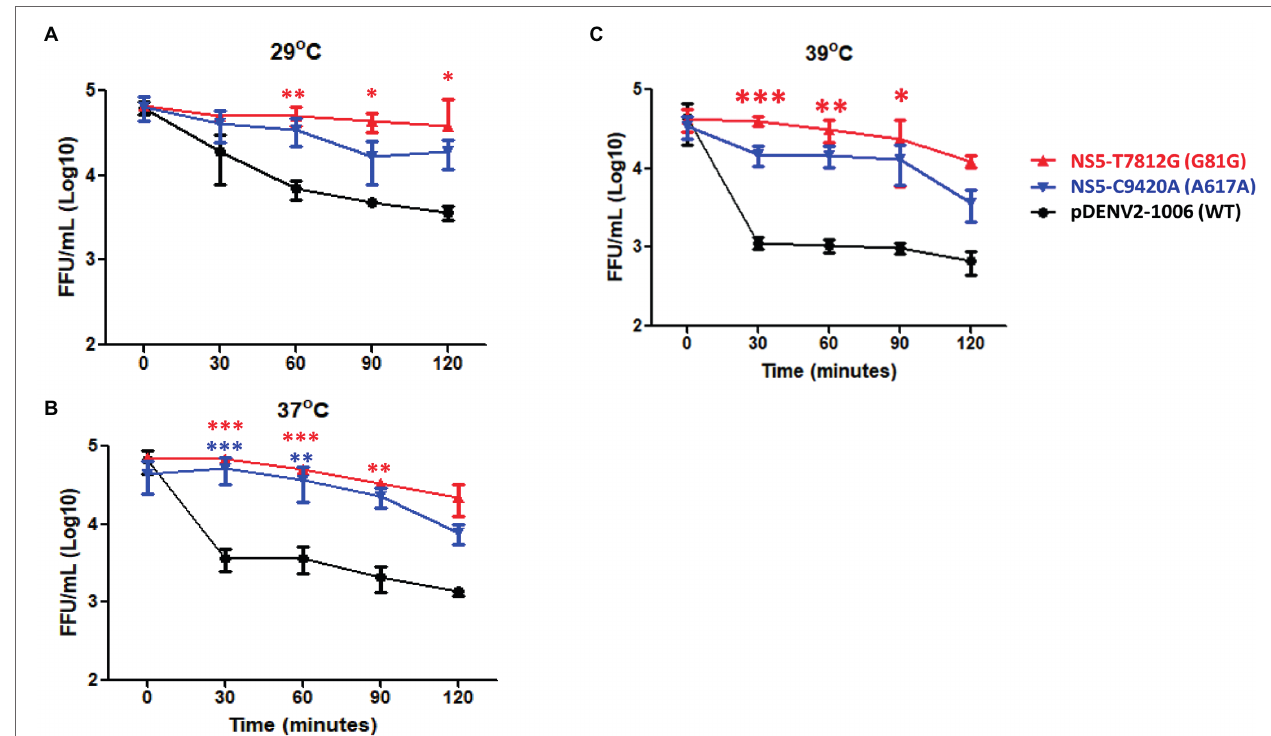
FIGURE 6 | Thermal stability of virus variants and WT virus. Viruses were incubated at (A) ∆ 29 ° C, (B) ∆ 37 ° C and (C) ∆ 39 ° C for 0, 30, 60, 90, and 120 min using a thermocycler. Post incubation period, viral titers were quantified in Vero cells to determine the number of infectious viruses remaining. Titers were calculated for FFU/ mL. The triangle, inverted triangle, and circle symbols represent NS5-T7812G (G81G), NS5-C9420A (A617A), and pDENV2-1,006 (WT-NS5-7812 T/9420C) variants, respectively. Statistical analysis comparing mutants with wildtype was calculated using one-way ANOVA. * p < 0.05, ** p < 0.01, and *** p <